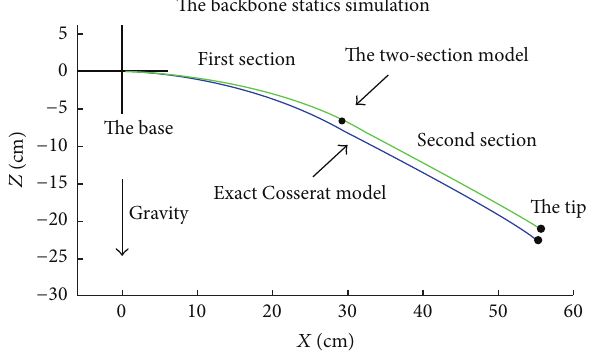
Figure 9: Comparison of an exact solution, with the proposed model in statics